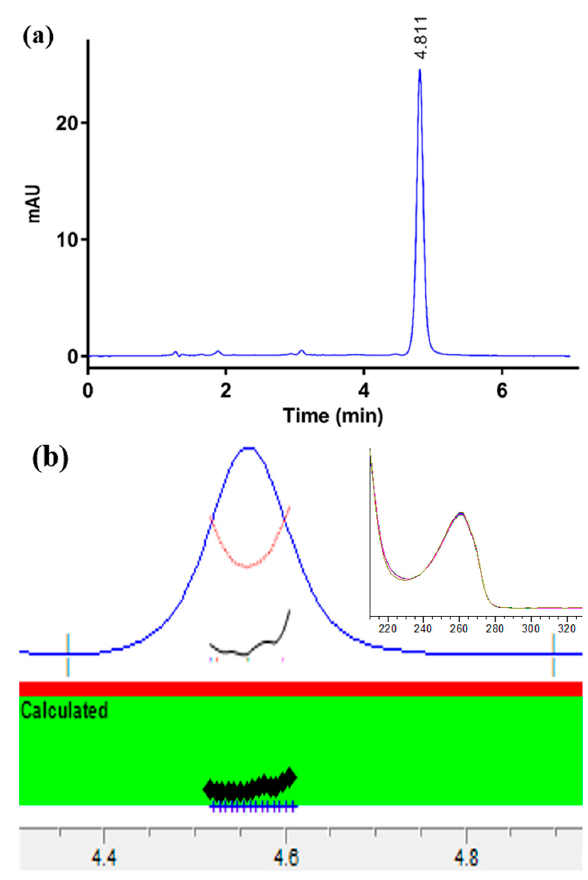
Figure 2. ( a ) Chromatogram of nicotine (20 μ g/mL) and ( b ) peak purity profile (red line) of nicotine showing the purity value within the threshold limit. The insert shows the overlapping of different spectra.